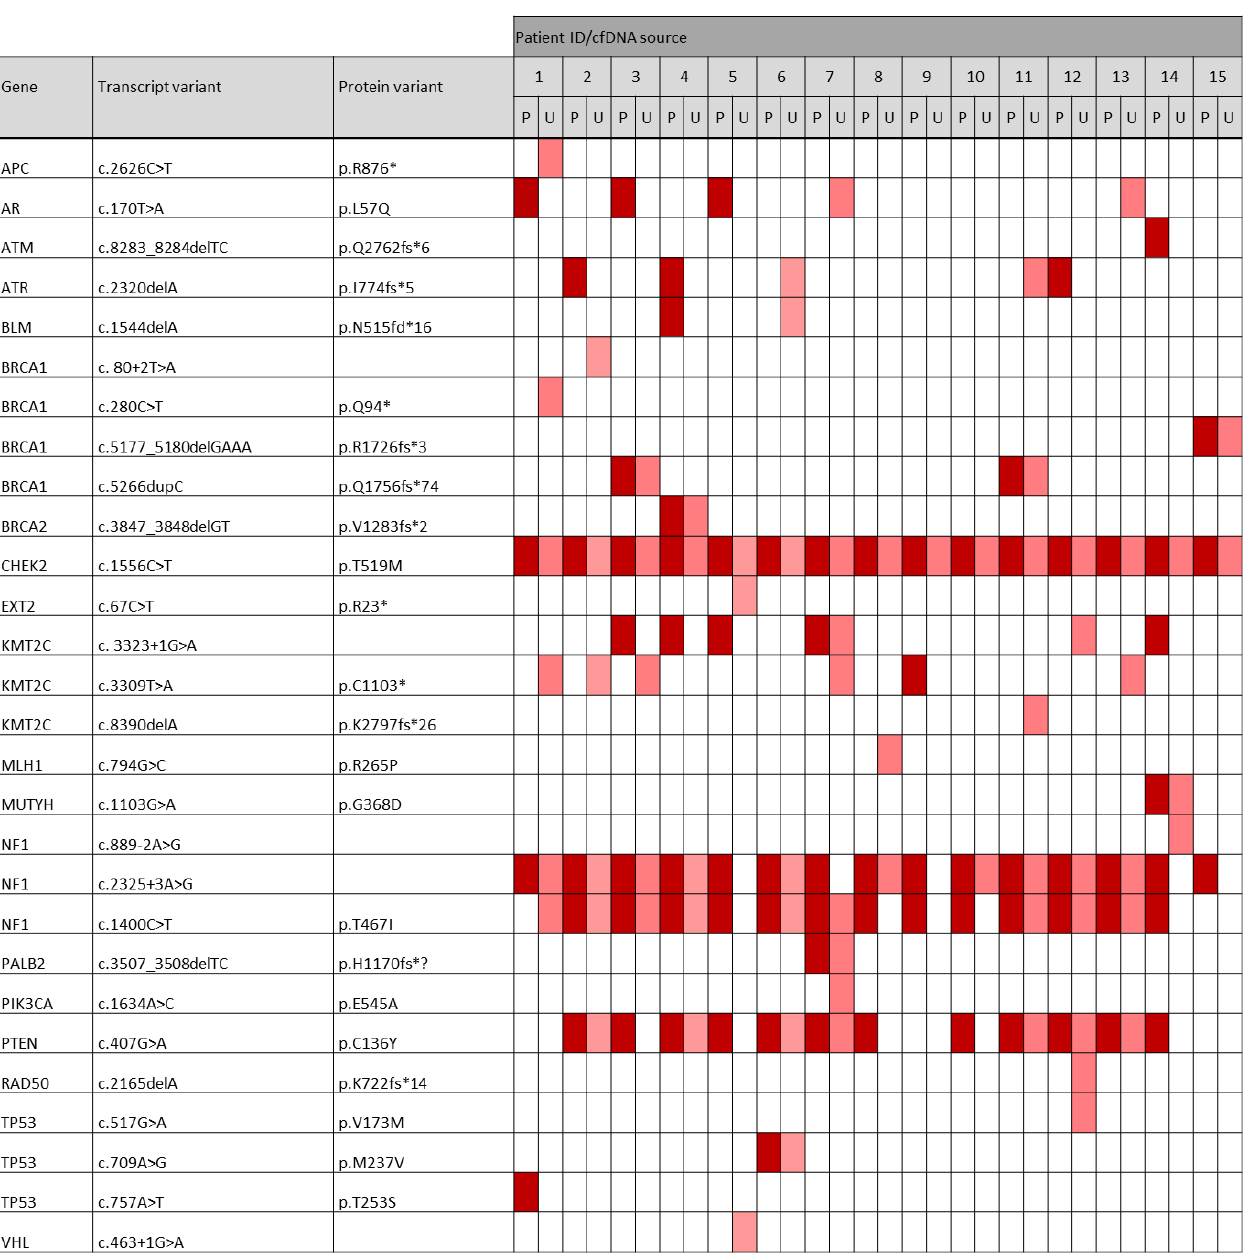
Figure 7. Heatmap of all pathogenic variants found in plasma ctDNA ( p ; dark red) and ctDNA of the matching urine samples (U; light red). In both body fluids, a median of 5 pathogenic variants were found, ranging from 3–8 variants in plasma ctDNA and from 1–8 in urinary ctDNA. Notably, when comparing pathogenic variants found in plasma and the matching urine sample per patient, 63% of pathogenic plasma variants could be detected in the matched urine samples and vice versa, and the recovery rate of pathogenic urine-derived variants in plasma cfDNA was